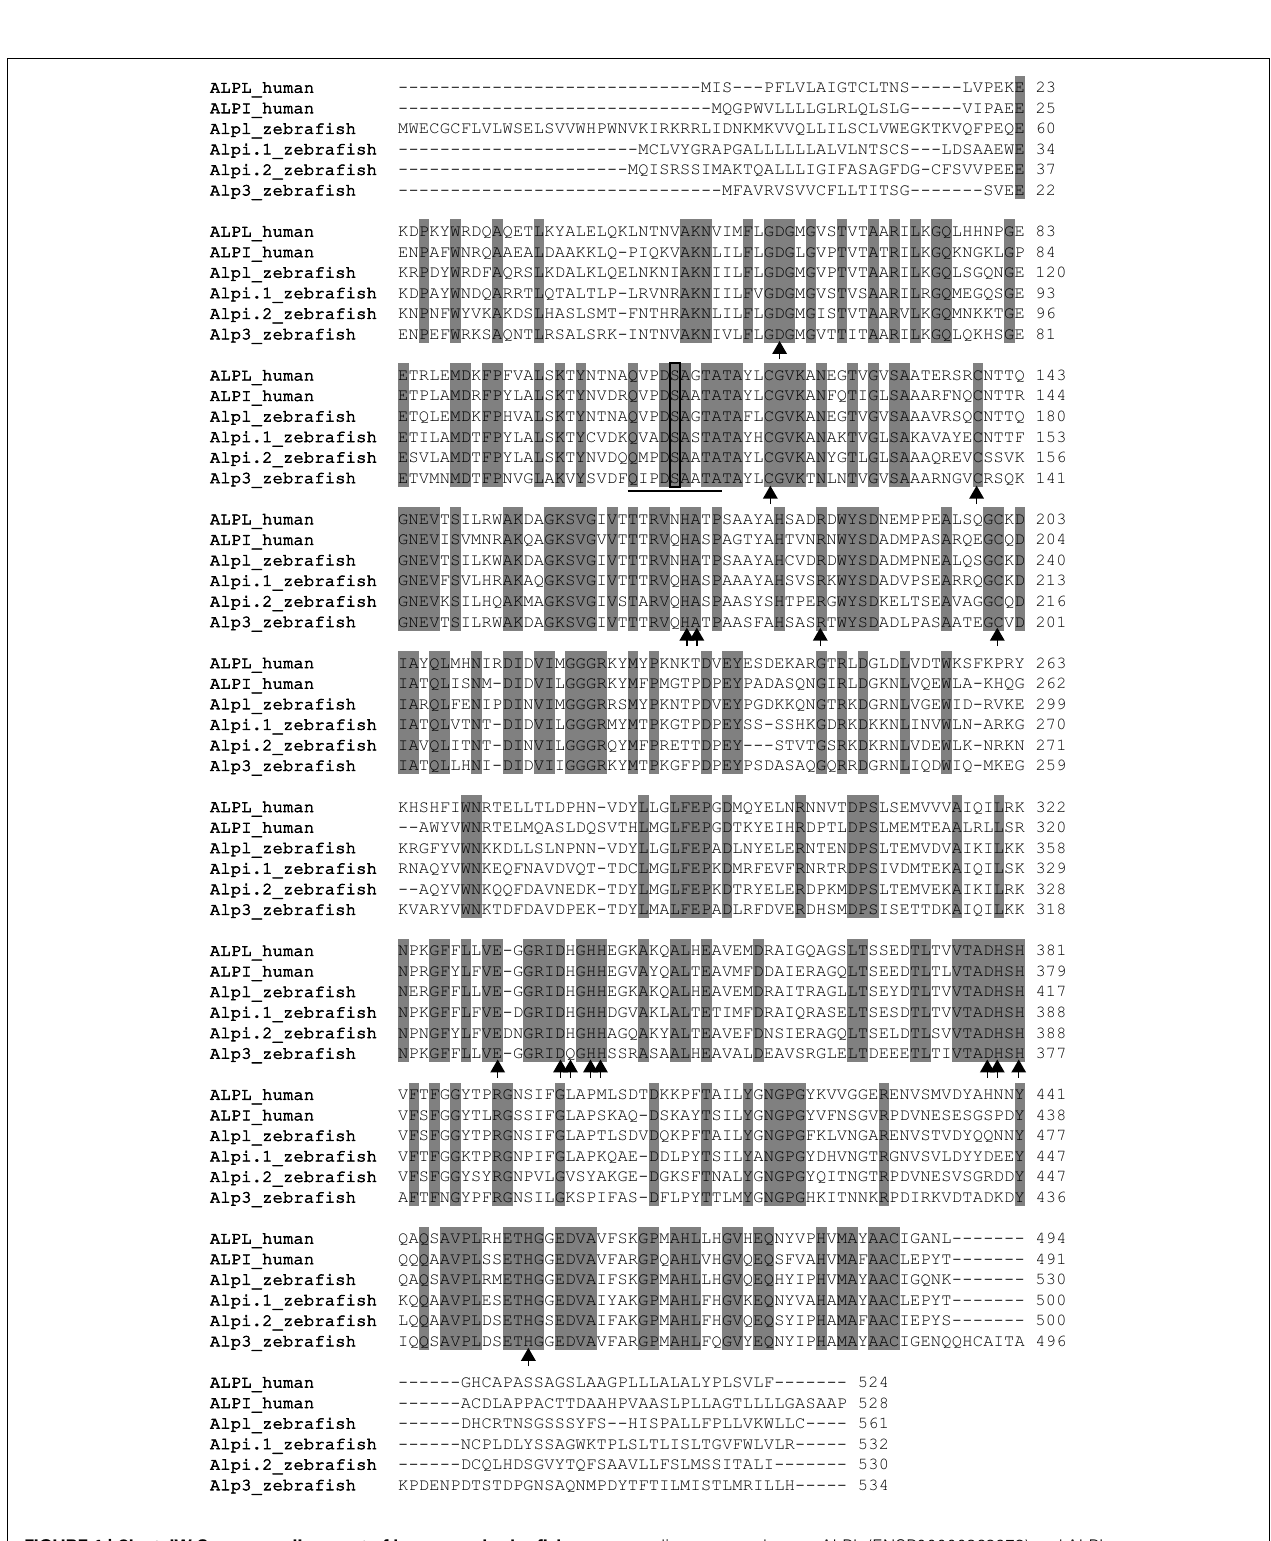
FIGURE 1 | ClustalW Sequence alignment of human and zebrafish Alps. Identical amino acids are shaded gray, putative metal-binding sites are indicated by arrows, active sites are underlined, and the conserved serine required for enzyme activity is boxed.The proteins used in the